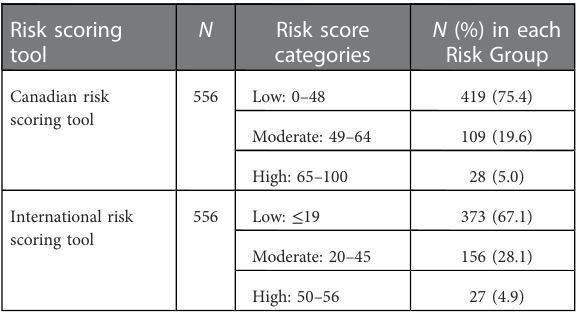
TABLE 2 Classi fi cation of infants by risk category using the Canadian vs. International Risk Scoring